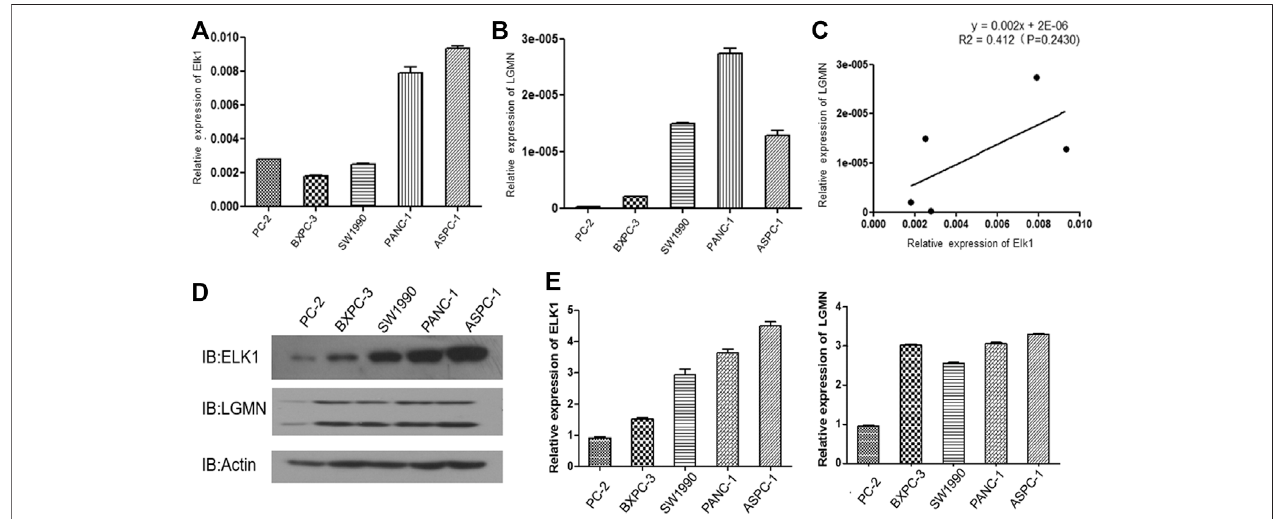
FIGURE2| ELK1positivelycorrelatedwithLGMNexpressioninpancreaticcancercells. (A , B) ELK1andLGMNexpressioninfourpancreaticcancercelllineswere detected by RT-PCR. (C) Correlation between ELK1and LGMN in pancreatic cancer cells were analyzed. (D , E) ELK1, LGMN expression and beta-catenin in four pancreatic cancer cell lines determined by Western